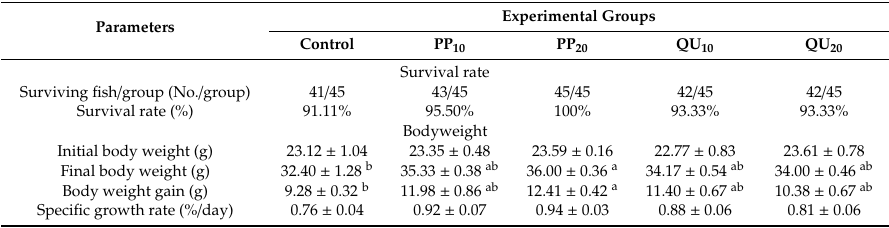
Table 2. E ff ect of PP or QU supplementation for 45 days on the survival rate and growth performance of Nile